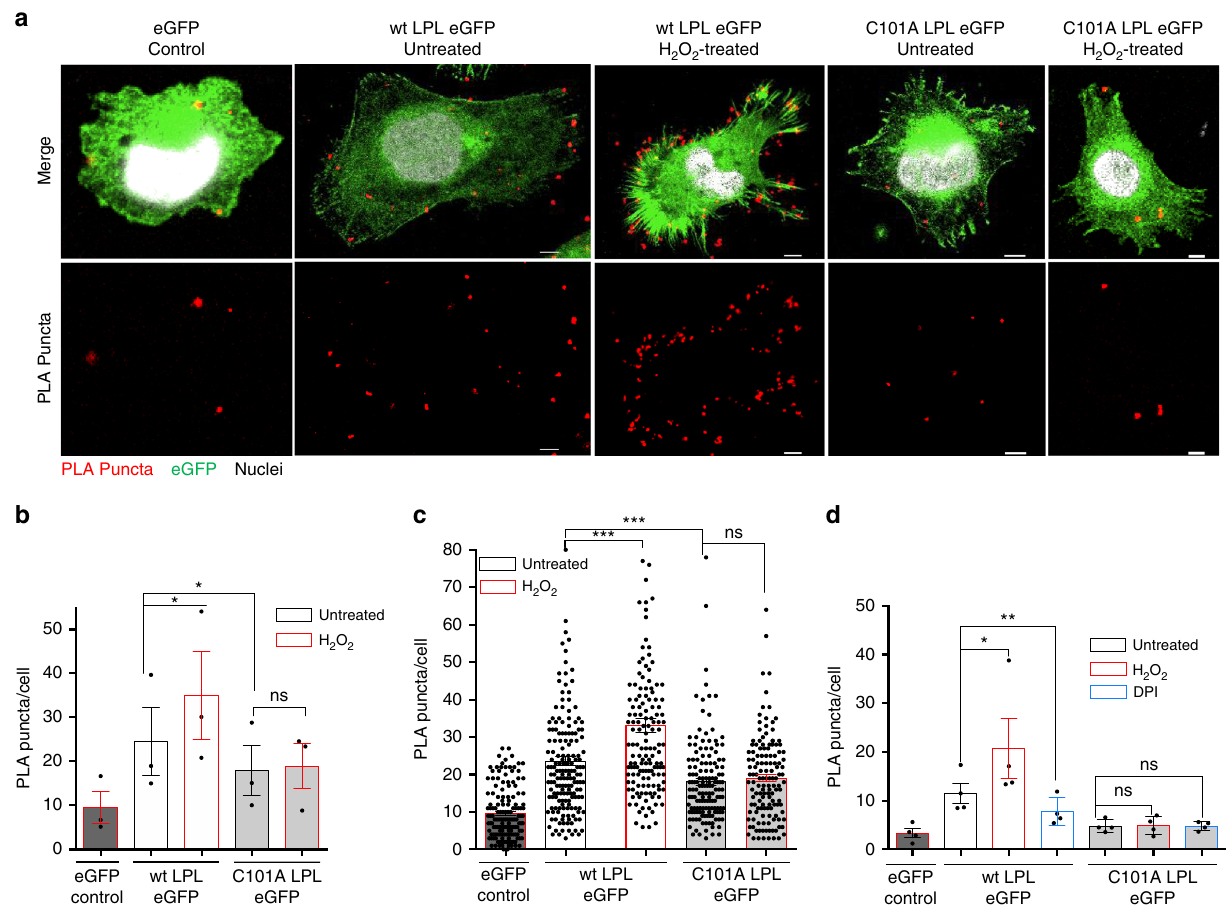
Fig. 6 Spatial oxidation of LPL at the cell periphery. a Confocal microscopy images of MV3 LPL eGFP cells upon PLA staining. Cells were kept untreated or were treated with 100 µ M H 2 O 2 . Then, the cells were fi xed with PFA in the presence of 5 mM dimedone and stained for LPL and dimedone with speci fi c antibodies and subjected to PLA. Ten xyz optical sections/sample were imaged in each experiment using confocal microscopy. Representative images of eGFP-, wt LPL eGFP-, and C101A LPL-expressing MV3 cells in the absence and presence of H 2 O 2 are shown. Shown are nuclei (white), LPL eGFP (green) and PLA puncta (red). Each red punctum represents sulfenylation on LPL. Scale bar = 5 µ m; ×100 magni fi cation. b, c Quanti fi cation of the PLA puncta/cell in the presence or absence of H 2 O 2 . b Fifty cells were imaged in each of three independent experiments. Each dot in the histograms represents the average PLA puncta/cell for a different experiment. c Cumulative comparison of the PLA puncta/cell values in eGFP-, wt LPL eGFP-, and C101A LPL eGFP- expressing MV3 cells in the absence or presence of H 2 O 2 . A total of 150 cells/sample from three independent experiments were imaged. Each dot represents a cell from one of three experiments. d Quanti fi cation of the PLA puncta/cell in untreated versus DPI- or H 2 O 2 -treated MV3 cells